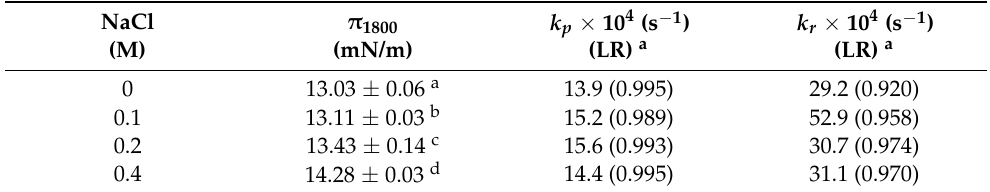
Figure 7. Interfacial pressure of SPPH at the water/oil interface at 20 °C, pH 7.2, and at 0 ( grey line ), 0.1 ( red line ), 0.2 ( blue line ) and 0.4 M ( green line ) NaCl over 1800 s. π values close to zero were not detected, indicating a good surface activity of SPPH. Table 2. Characteristic parameters for the adsorption of SPPH (0.5%) at the water/oil interface at 20 ◦ C, pH 7.2, and varying salt concentration. a LR = linear regression